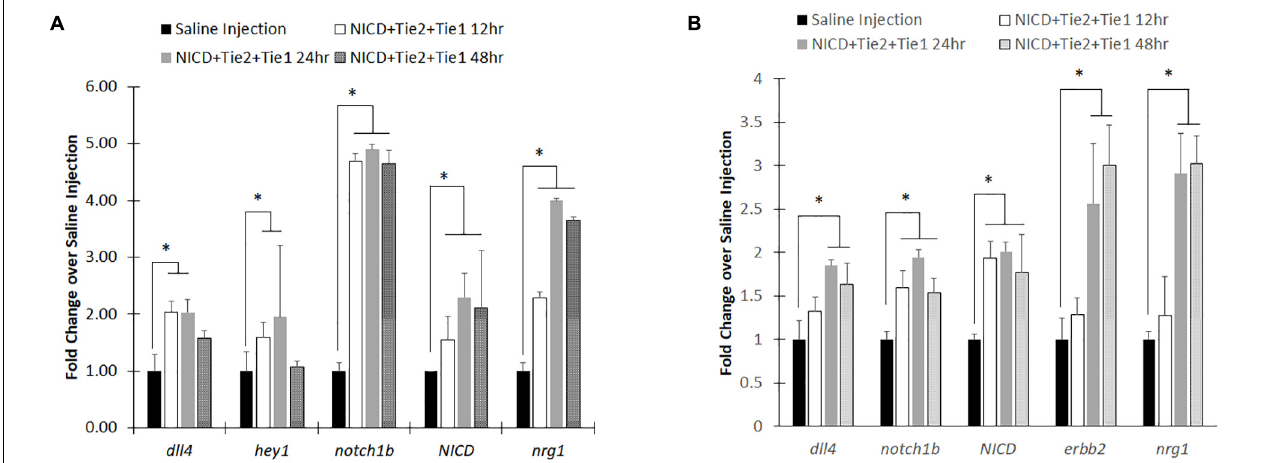
FIGURE 4 | RT-PCR analysis after injecting intravenous NICD loaded nanoparticles. (A) Notch signaling components were all upregulated after injection of NICD loaded nanoparticles until 24 h post injection. However, Notch ligand ( dll4 ) and receptor ( notch1b ) were returned to control group (saline injection) level while downstream components ( nrg1 and hey1 ) remain high with NICD expression level. (B) Isolated zebrafish heart after injection showed higher expression levels of Notch components to increase cardiac function. Interestingly, endocardial nrg1 -myocardial erbb2 signaling components consistently increased up to 48 h post injection. * indicates a significant difference ( p < 0.01). n =